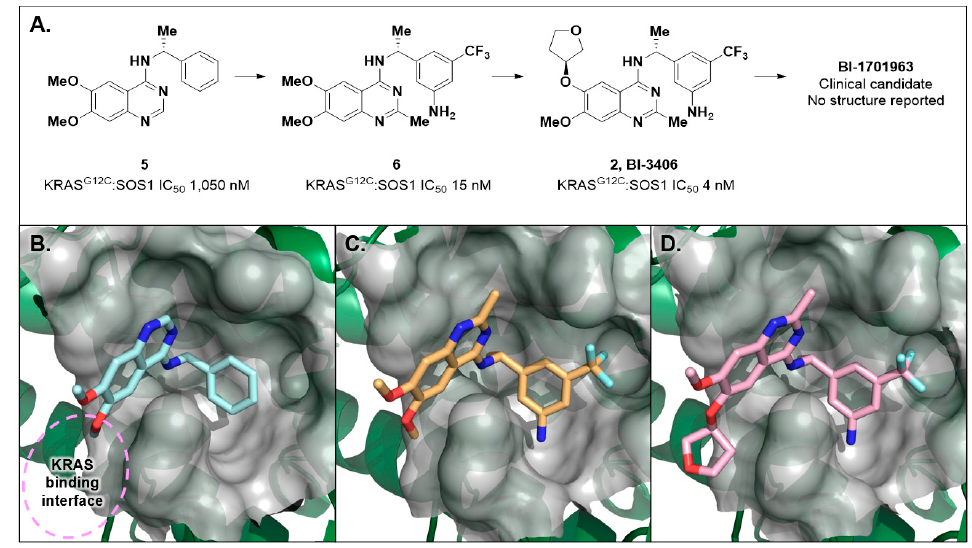
Figure 4. ( A ) Optimization of HTS hit 5 through 6 and BI-3406 ( 2 ) to identify the clinical candidate BI-1701963. ( B ) X-ray co-crystal structure of 5 bound to SOS1 (PDB: 6SFR) displays the same binding mode as 4 (Figure 3). ( C ) X-ray co-crystal structure of 6 bound to SOS1 (PDB: 7AVU). Note the Phe890 side chain prefers the Phe890-in conformation. The primary anilino group makes a productive hydrogen bond with the Met878 backbone carbonyl. ( D ) X-ray co-crystal of BI-3406 ( 2 ) bound to SOS1 (PDB: 6SCM). The tetrahydrofuran moiety is projected into space where KRAS binds to SOS1, thus disrupting the SOS:KRAS PPI.